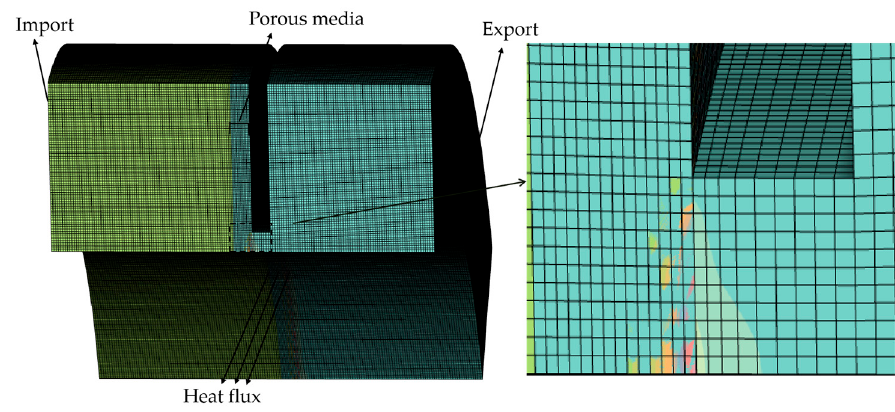
Figure 5. Numerical calculation model of the brush seal.